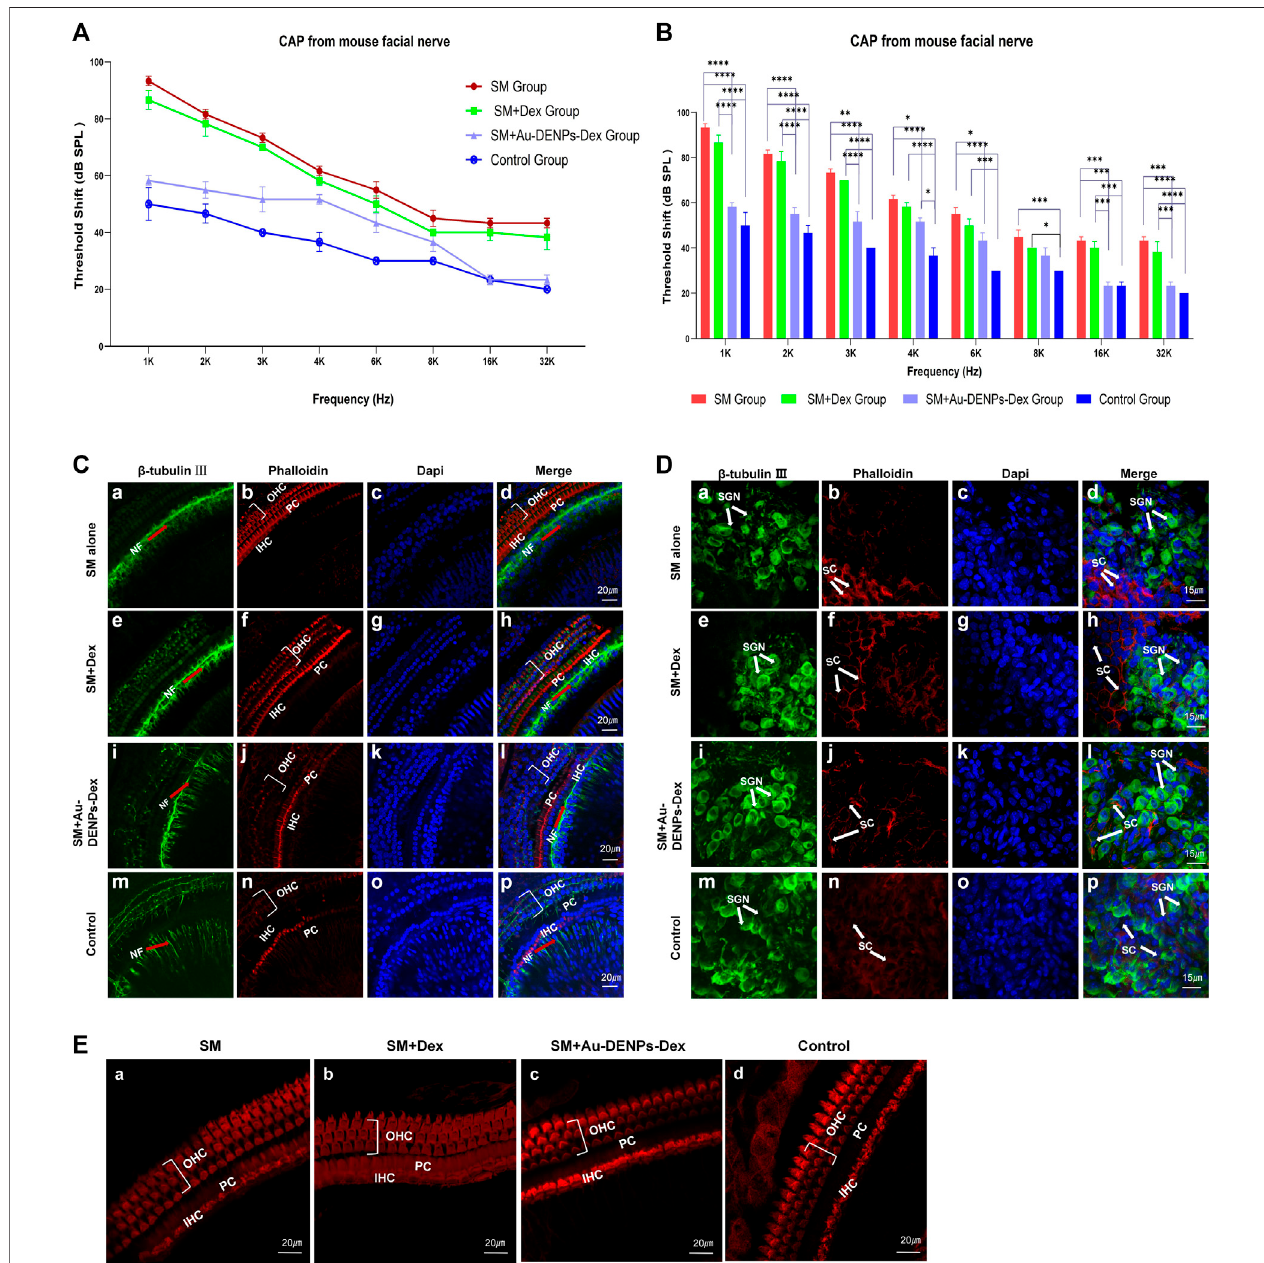
FIGURE 9 | (A) Rapid changes in the CAP threshold of mice recorded from the facial nerve after treatment with streptomycin alone, streptomycin mixed with Dex, andstreptomycinmixedwithAu-DENPs-Dex(Au@CD-PAMAM-Arg8/Dex). (B)